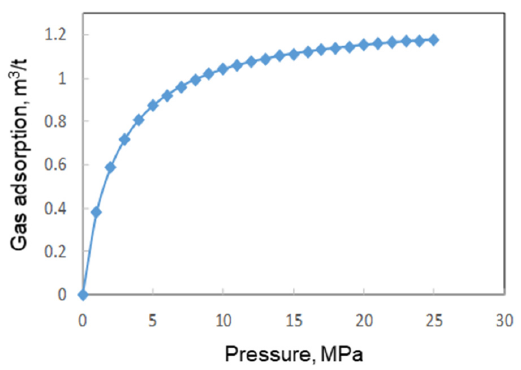
Figure 5. Shale gas adsorption curve of W Block based on experiments.